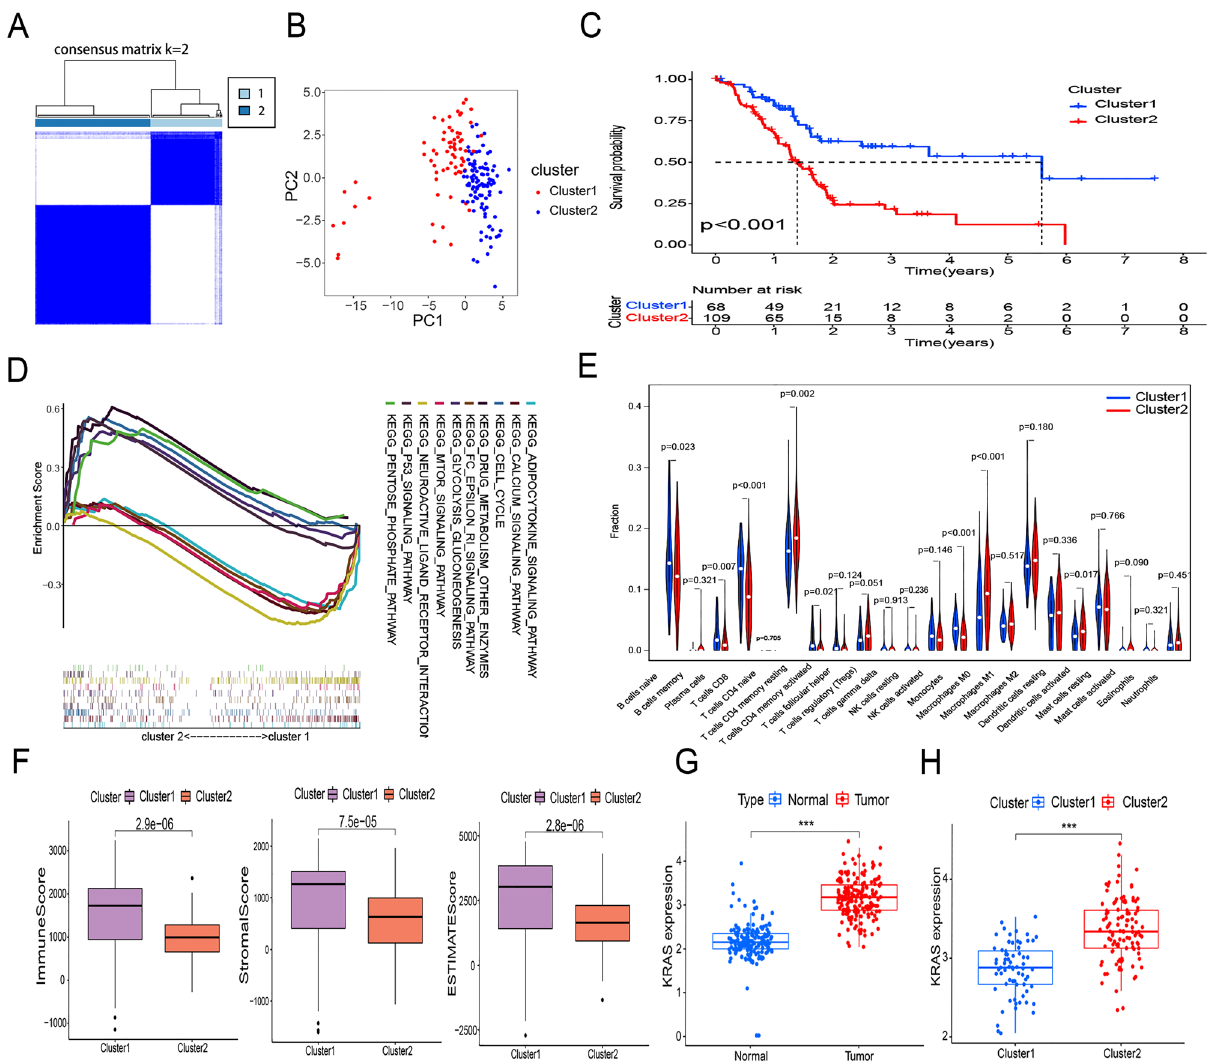
Figure 3. Prognosis and immune status of pancreatic cancer samples after clustering. *, **, ***, represent P < 0.05, P < 0.01 and P < 0.001. ( A ) Consistent clustering plot of pancreatic cancer samples. ( B ) Principal components analysis divided pancreatic cancer samples into Cluster1 and Cluster2. ( C ) Kaplan–Meier survival analysis for the two clusters (P < 0.001). ( D ) GSEA of Cluster1 and Cluster2. ( E ) Violin plot depicting the differential analysis of immune cell expression in the two clusters. ( F ) Boxplot of immune infiltration scores for Cluster1 and Cluster2, showing a significant between-group difference. ( G , H ) Boxplots of differences in KRAS genes between normal and pancreatic cancer samples, as well as between the two